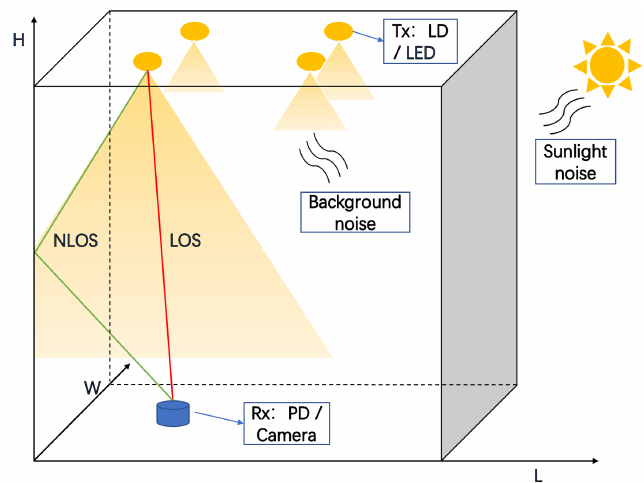
Figure 13. General architecture of indoor OWC systems.